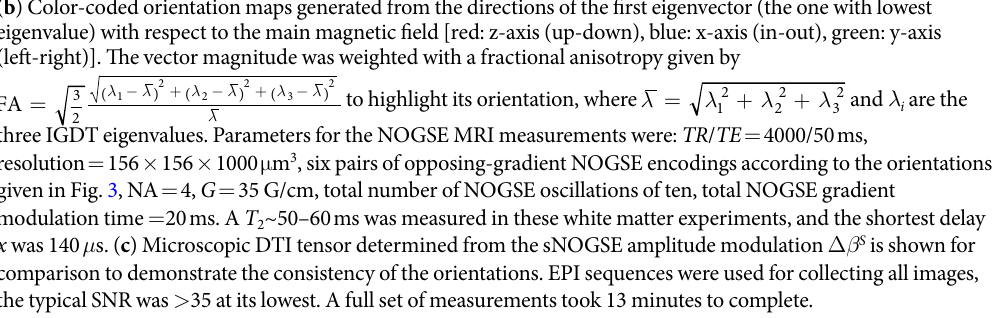
to complement anisotropic scenarios where DTI effects are tenuous, i.e., where diffusion path lengths do not extend far enough to probe a pore’s boundary constraint. In particular, IGDT determinations in high-field scenarios could allow one to measure oriented morphologies whose diameters exceed ≈ 50–100 μ m filling the gap of resolutions between conventional imaging ( > 100 μ m) and DTI-based imaging ( < 50 μ m). This method could also show impor- tant benefits in non-invasive studies using ultra-high field MRI of structured systems, including studies of porous media and living tissues, where B 0 -magnified internal gradients could serve as fingerprints of a system’ s composition and structure. The success of these measurements will naturally depend on the strength of the background gradients and on their gradient-distribution variances; i.e., they will strongly depend on the nature of the sample of interest. The approach’s success will also depend on ensuring that the relative change of the diffusion-weighting attenuation factors arising due to the cross-term interference between the applied and background gradient, are larger than the inverse of the signal-to-noise-ratio of the spin signal. This need for the changes being sought to exceed the experimental uncer- tainties, will in turn define the optimal magnetic field strength and/or external gradient that should be used to best exploit this methodology; in principle it would appear that higher fields would invariable help to define the observa- ble, yet further research is needed to assess this. Further interesting options arise if spin-diffusion 53 – as opposed to physical diffusion– is used as probing mechanism; in such instances much finer decoherence phenomena such as those arising from anisotropic susceptibilities, could become observable for the first time.